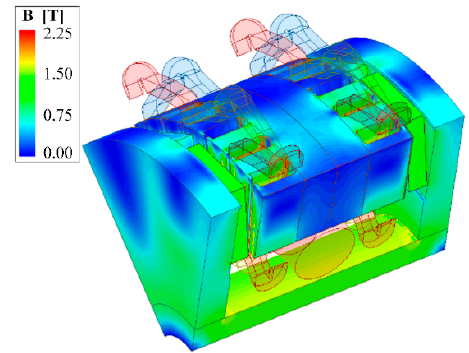
Figure 12. Distribution of magnetic induction in a machine for the unpowered DC coil.